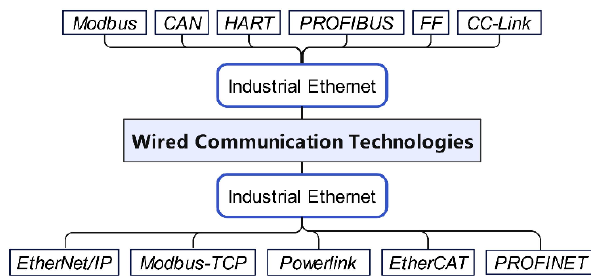
Figure 5. Wired communication technologies.